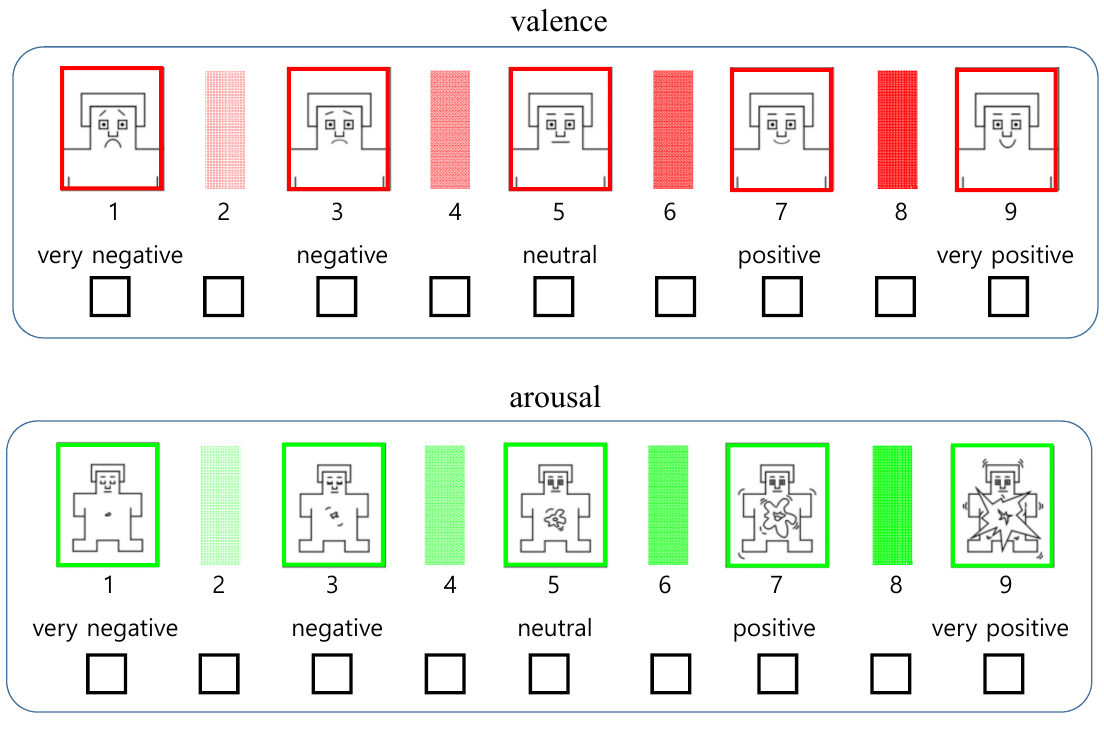
Figure 6. Nine-point metric for user annotation. Table 1. Gender and age distribution of the participants.